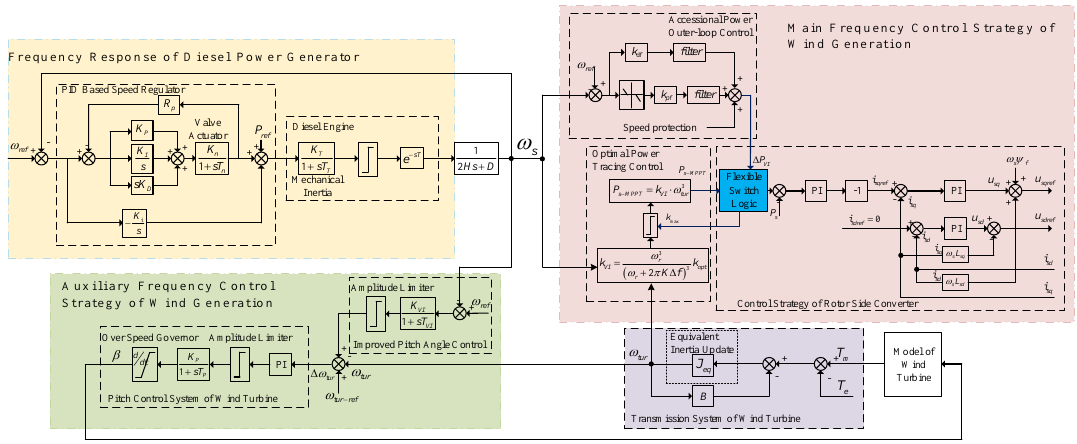
Figure 7. Coordinated frequency control strategy for WPG participating in the black start procedure.